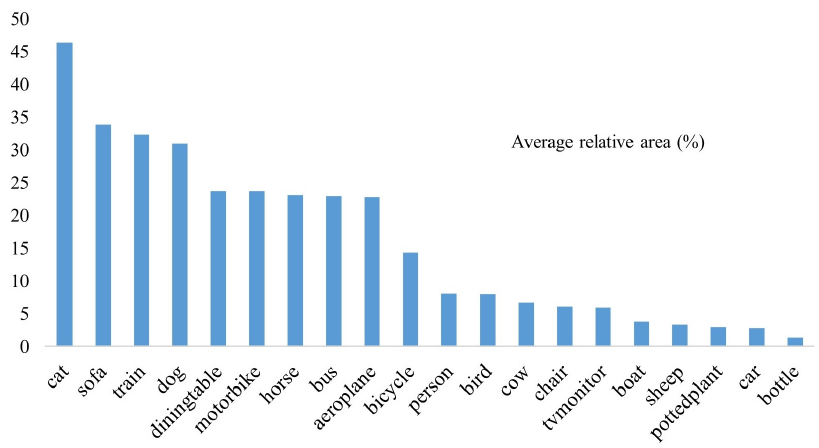
Figure 8. Average relative area of object categories in the PASCAL VOC